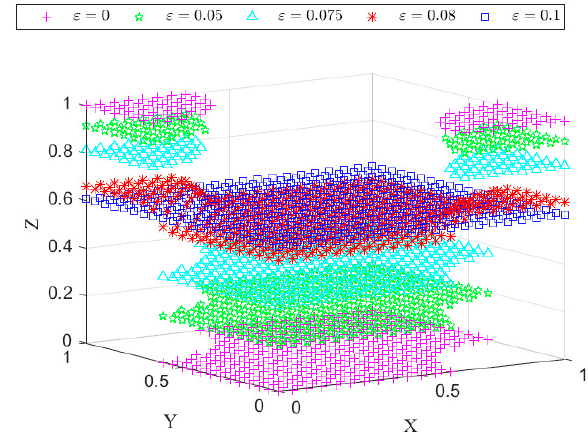
Figure 8. 3-D diagrams of XOR multiplexing for X , Y and Z .